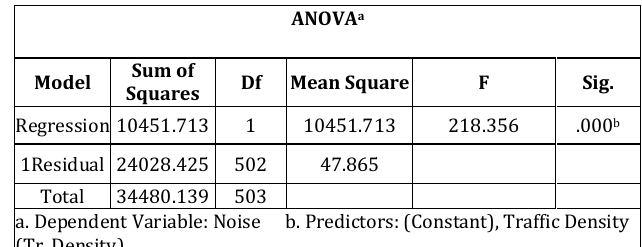
Table 2: ANOVA Test for Average Noise Level and Traffic